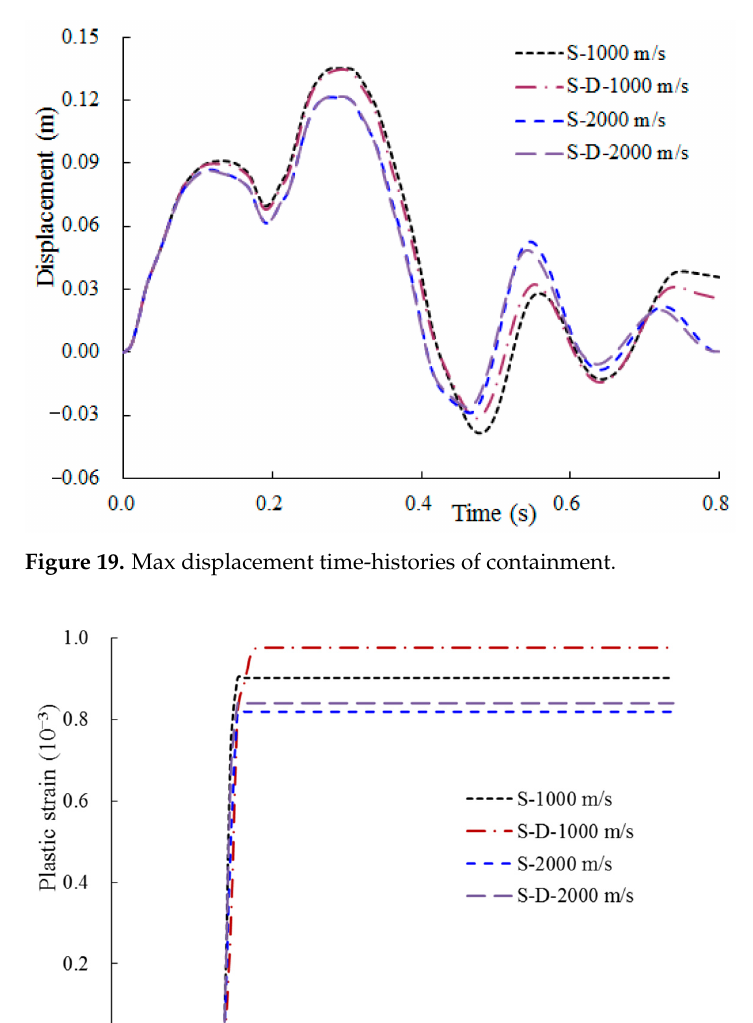
Figure 21. The spring-damper energy and spring energy for the sites of Vs = 1000 and 2000 m/s.